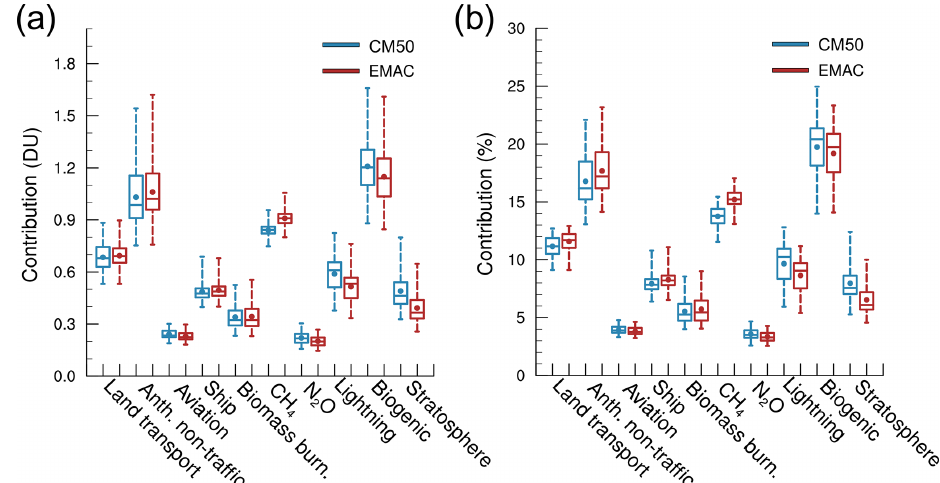
Figure 7. Box-and-whisker plot for (a) the absolute (in Dobson units) and (b) relative (in percent) contribution to the ozone column up to 850hPa. The values are area averaged over the CM50 domain. The lower and upper ends of the boxes indicate the 25th and 75th percentiles, the middle bars represent the medians, the dots represent the average, and the whiskers represent the ranges of the time series for the JJA values from 2008 to